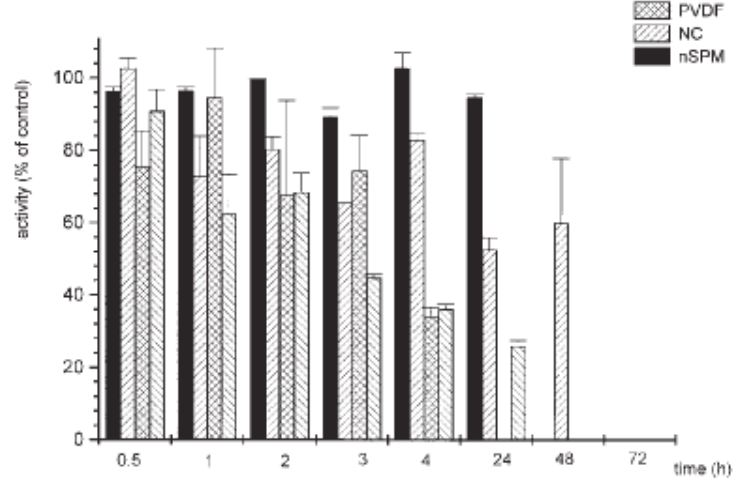
Figure 8. Stability of the Na + ,K + -ATPase activity of native SPM (nSPM) and adsorbed SPM (aSPM) on different supports as a function of time after adsorption. Reproduced from